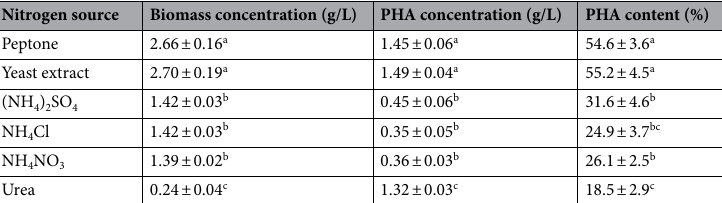
Table 4. Effect of nitrogen sources on the growth and PHA synthesis of Pichia sp. TSLS24. In a column, data with different superscript are significant with P <